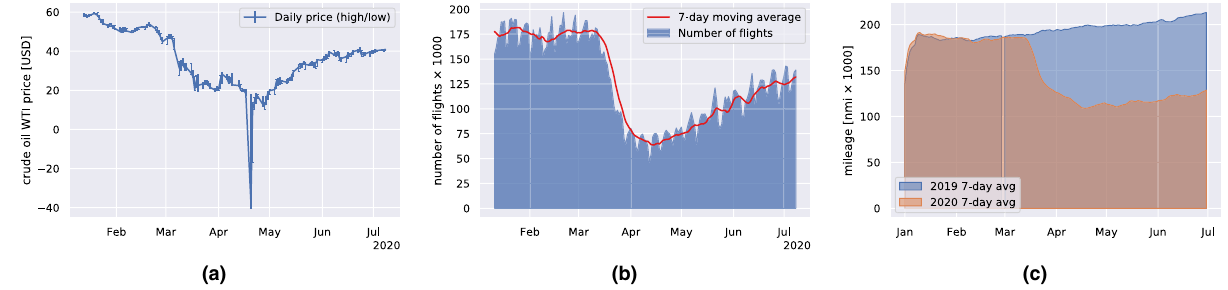
Figure 1. ( a ) Crude oil WTI price from January to July 2020 8 . Note the sudden and unprecedented negative price in April 2020. ( b ) Total number of flights tracked by FlightRadar24 from January to July 2020 9 . At the end of March there was an abrupt decrease of the number of flights ( ∼ 100,000 units) because of the lockdown restrictions. ( c ) Daily navigated miles by passenger ships in 2020 compared with